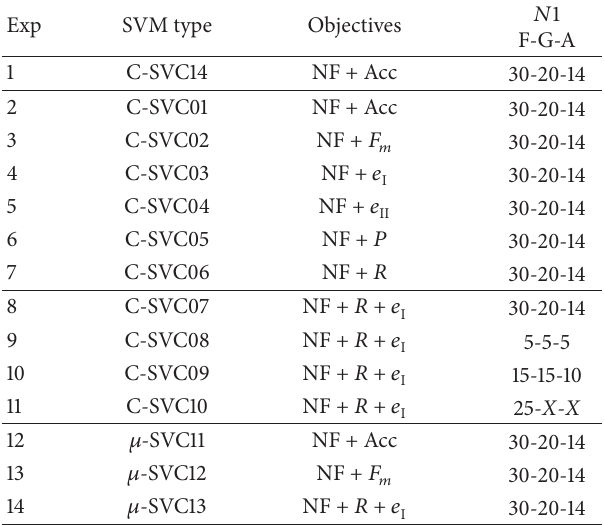
Table 2: Set of features considered for the German Credit. Table 3: Set of computational experiments ( N 1 is the maximum number of features in the initial population; X means experiment not